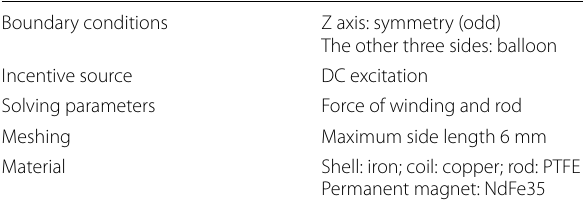
Figure 4 Meshing diagram of double rods electromechanical converter Table 1 Main parameters